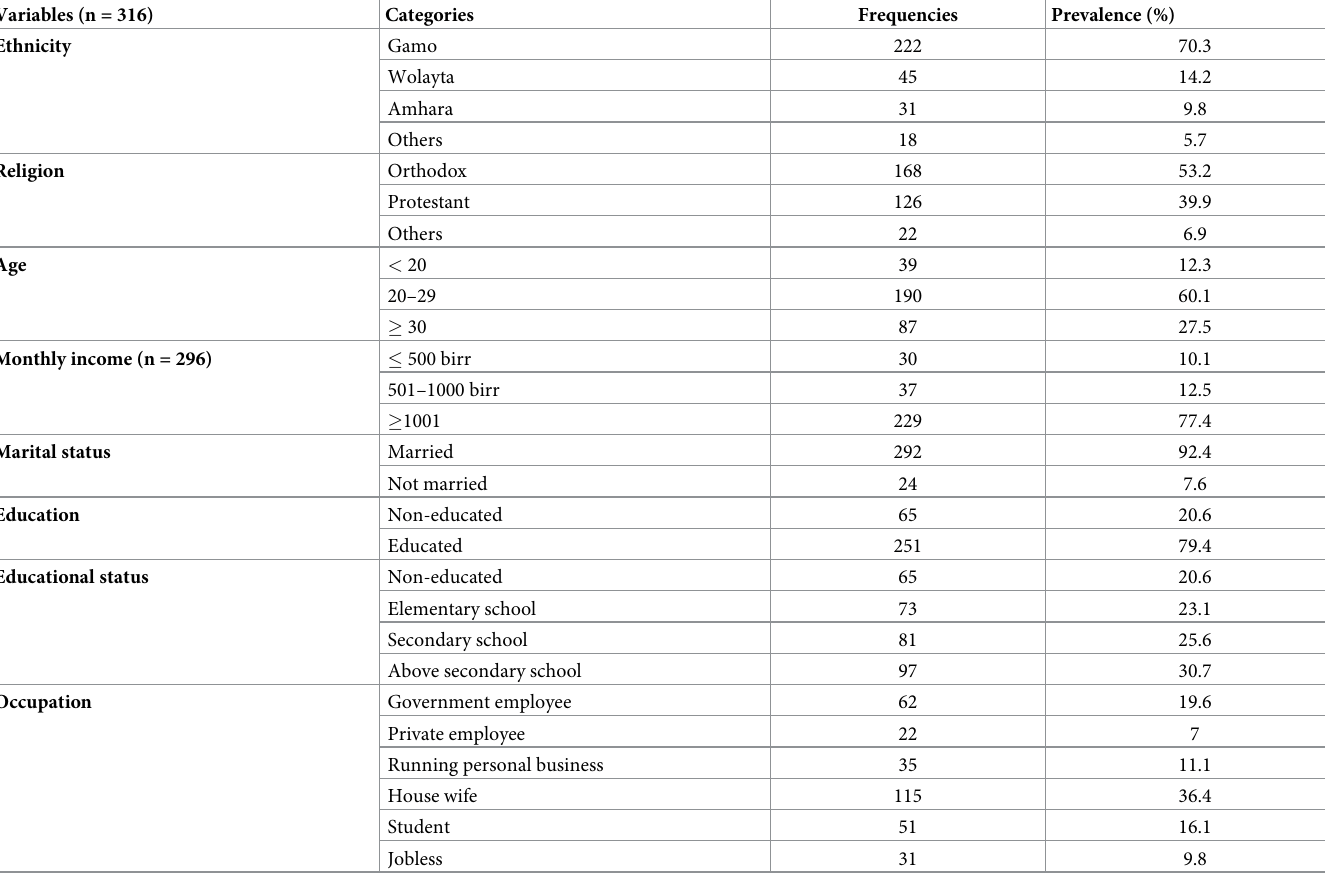
Table 1. Socio demographic characteristics of pregnant women attending public health facilities in Arba Minch SNNPR Ethiopia